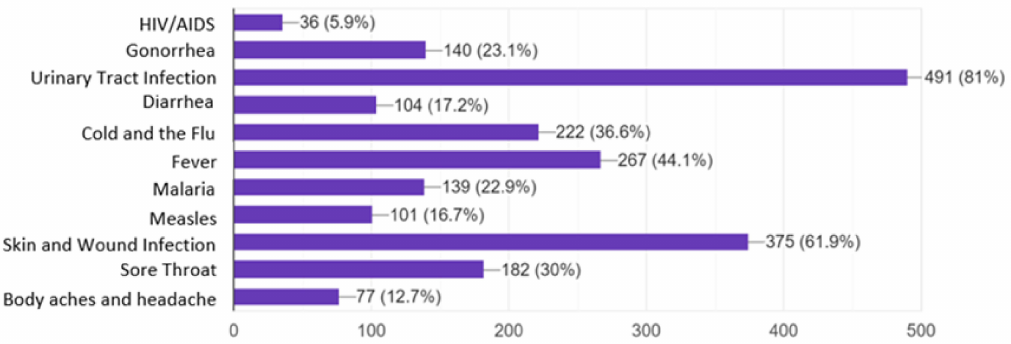
Figure 1. Level of knowledge on conditions that can be treated with antibiotics ( x -axis shows number of